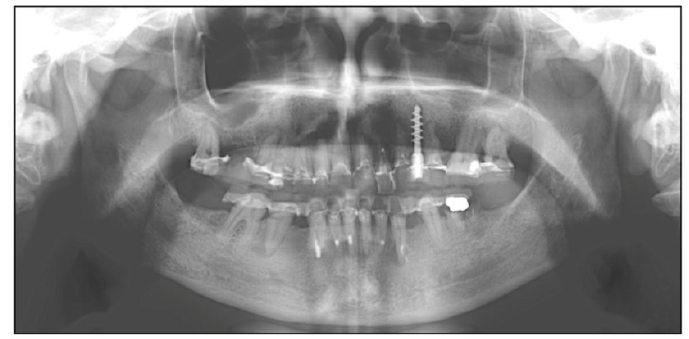
Figure 2. Preoperatory panoramic radiograph.